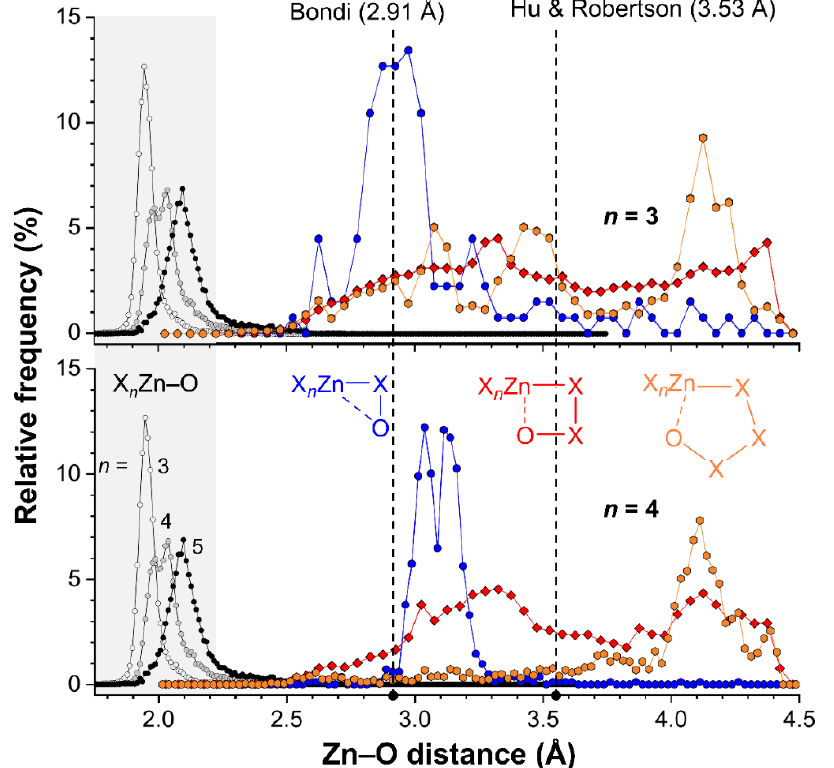
Figure 8. Plots of the relative frequencies as a function of the Intramolecular Zn ∙∙∙ O distances for tetracoordinated (top) and pentacoordinated (bottom) Zn complexes where Zn and O are separated by two (blue circles), three (red diamonds) or four (orange hexagons) bonds. For reference purposes, the distribution of the Zn–O bond lengths found in complexes ZnX 4 (white circles) ZnX 5 (grey circles) or ZnX 6 (black circles) are also plotted (highlighted in grey, X can be any atom). The dashed vertical lines indicate the sum of the van der Waals radii of O (1.52 Å) and Zn according to Bondi (1.39 Å) or Hu and Robertson (2.01 Å).